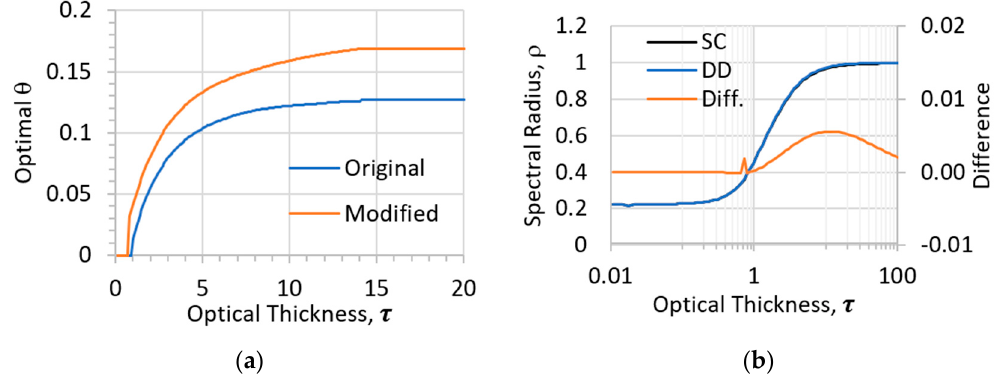
Figure 2. Results for the k-eigenvalue case. ( a ) Modified θ ; ( b ) Spectral radius of odCMFD scheme with the new θ function